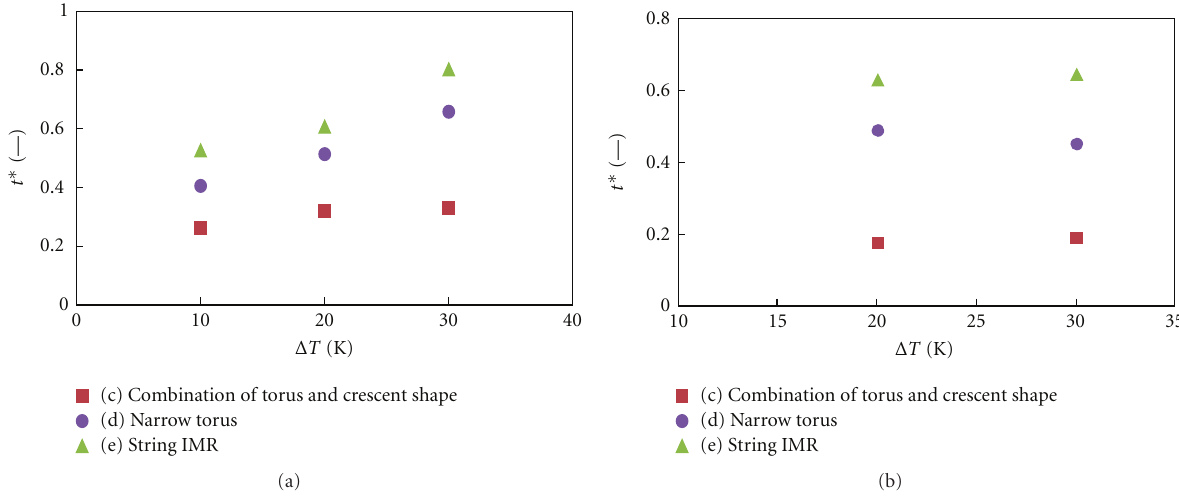
Figure 6: Dimensionless time as geometric structures of IMRs against temperature di ff erence: (a) the upper IMR and (b) lower